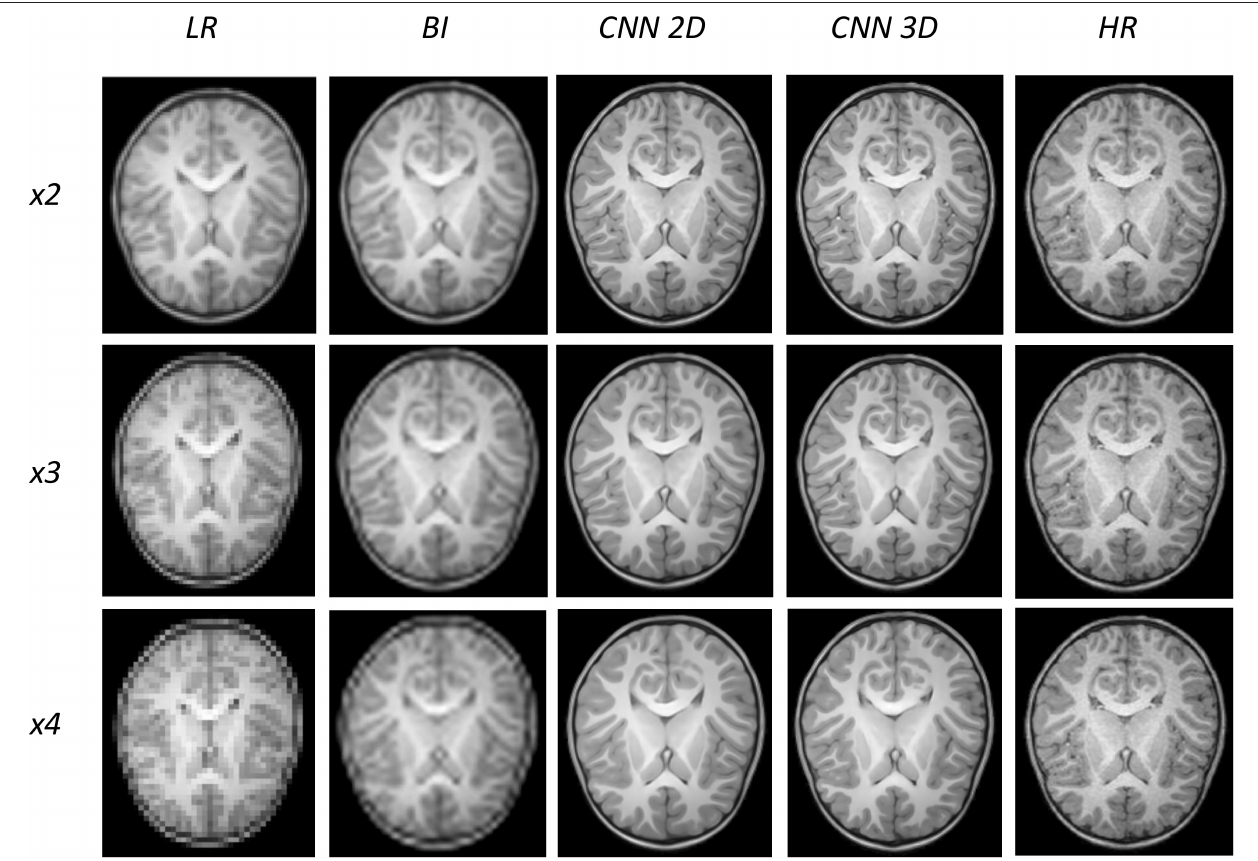
FIGURE 2 | Results of both CNN methods on three scaling factors of super-resolution. A representative slice is shown, together with the original high-resolution image, the low resolution image and the results of bicubic interpolation.